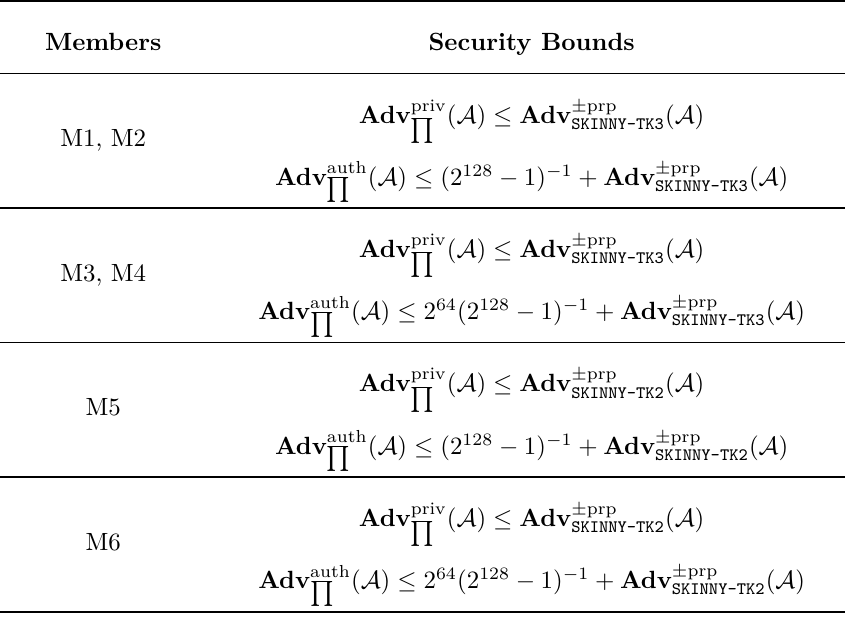
Table 6: Provable security bounds for our provided AEAD